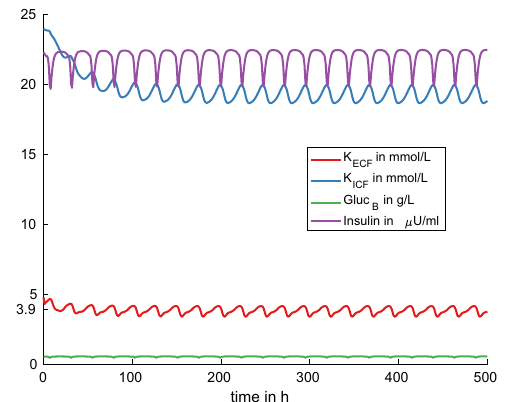
(b) Dynamics of intracellular potassium ( K ICF ) in mmol/L when the rate Keku is increased up to its 4-fold default value. With increasing KeKu , K ICF decreases faster at the beginning and than remains stable at lower values.